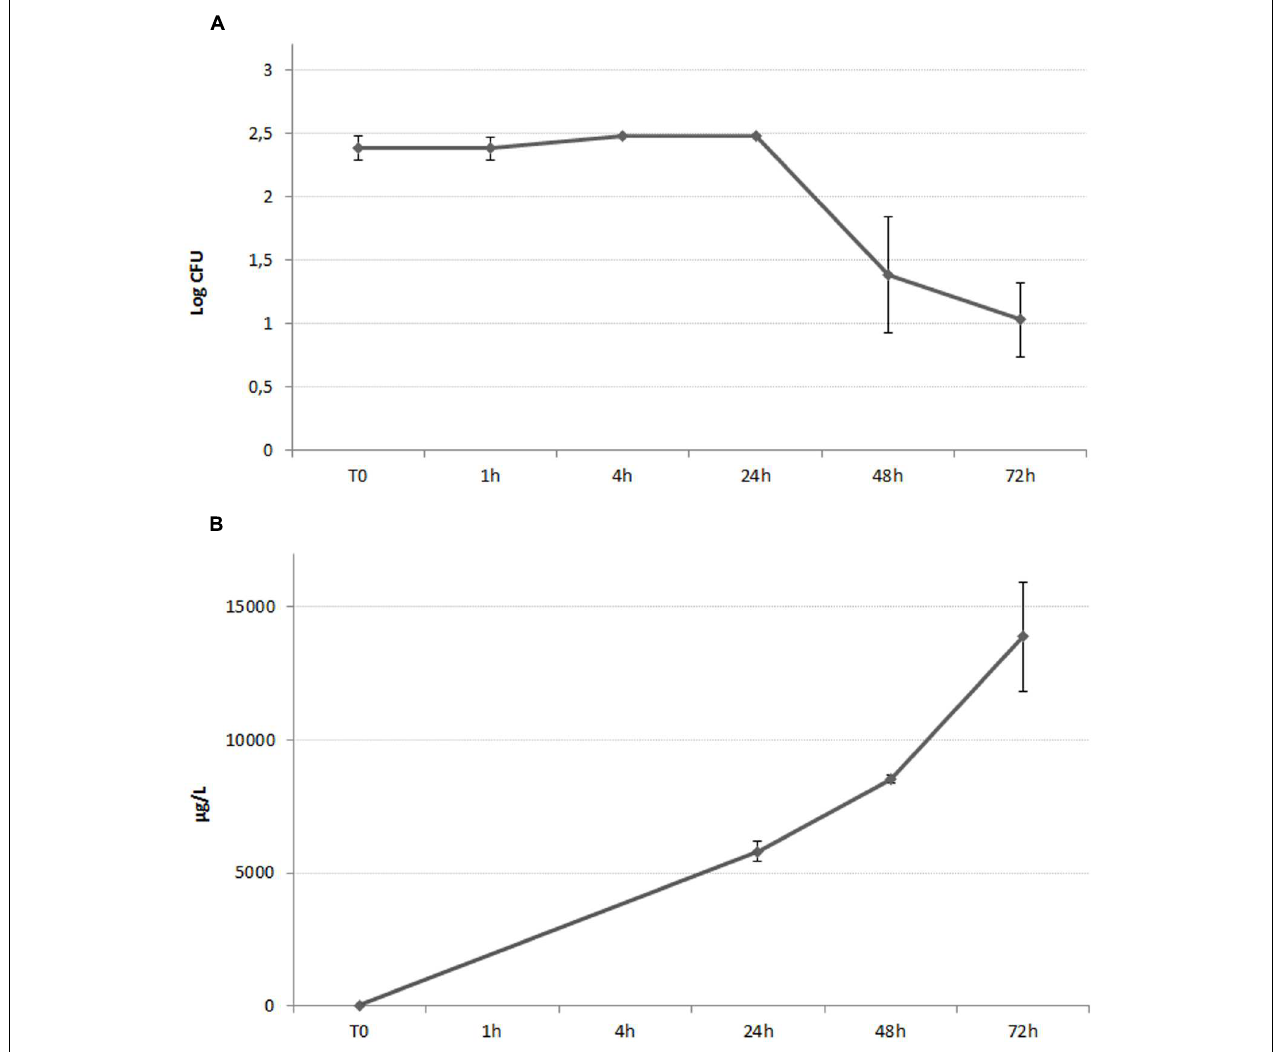
FIGURE 5 | (A) Growth curve of L. monocytogenes in the presence of AgNPs 300 ppm. The graphed values represents the mean of the counts belonging to L. monocytogenes strain n ◦ 5. (B) Time course assay of the silver ionic release of a 300 ppm suspension of AgNPs, incubated in the presence of L. monocytogenes isolate